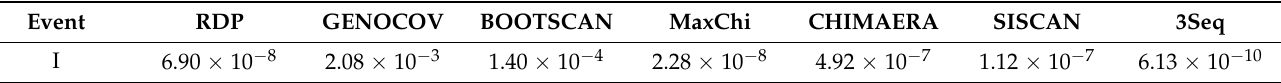
Table 2. Recombination events and the related average p -values calculated using different recombination detection methods.